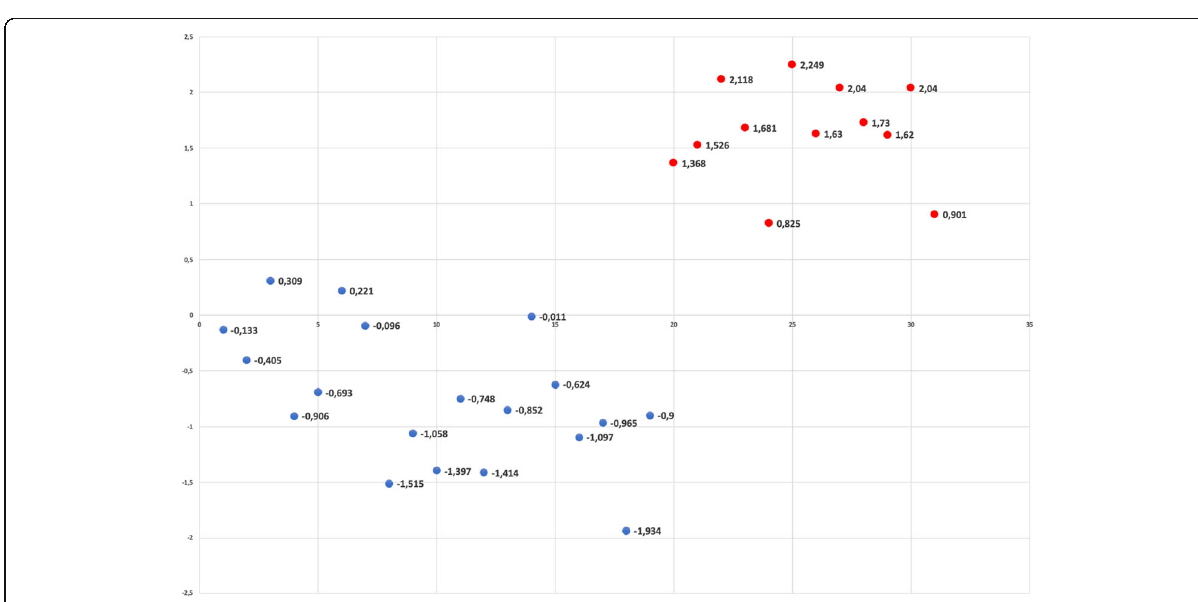
Fig. 4 Graphic representation of discriminant analysis scores: blue points RG; red points